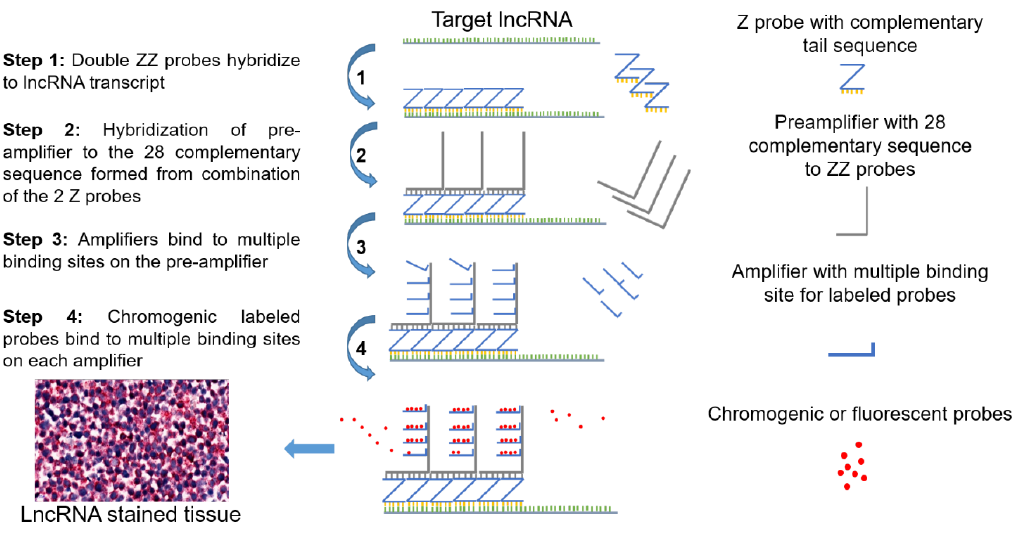
Figure 1. A schematic representation of the Z probe based RNAScope assay for long non-coding RNA